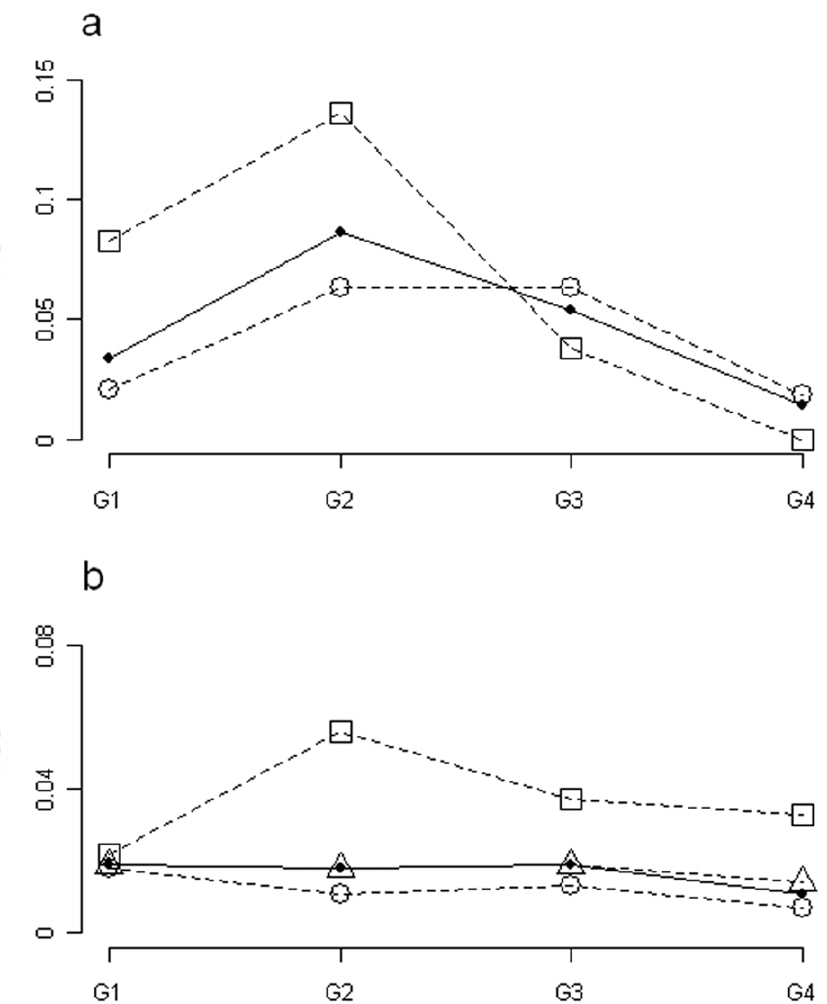
Figure 4. Importance of positive associations along grazing gradient. a, Rs , importance of positively associated species for each life form. b, Rss , positively associated pairs of species importance for each life form. G1 to G4 are the sampling sites. In a, importance of positive associations for species is evaluated for shrubs (open circles), grasses (open squares) and all species (black circles). In b, importance of positive associations for pairs of species is evaluated for shrub-shrub (open circles), grass-grass (open squares), shrub-grass (open triangles) and for all associations of pairs of species (black circles).